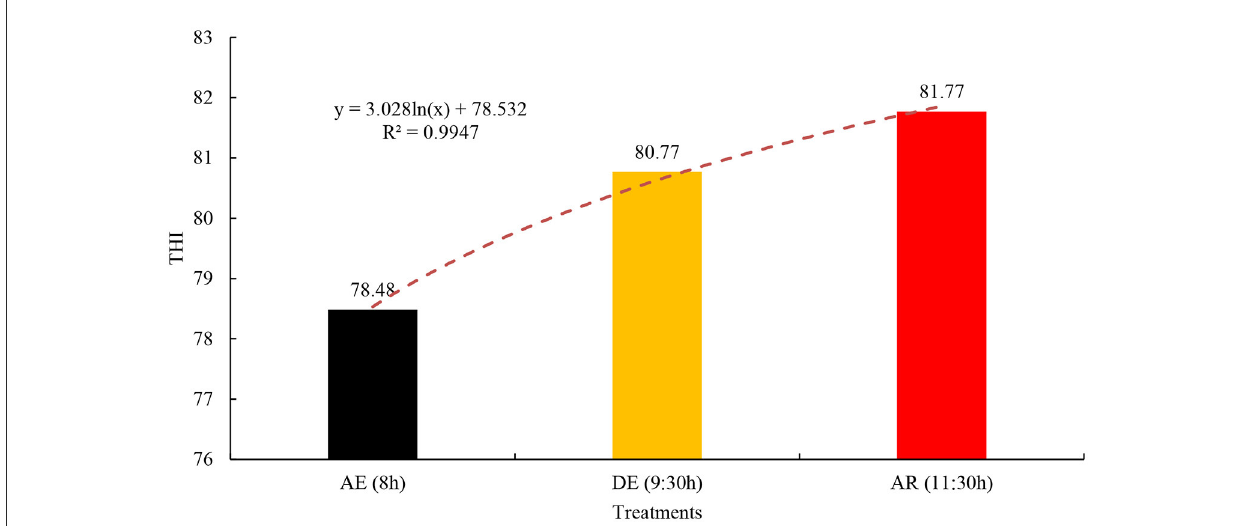
FIGURE1 Variation of the average values of the temperature and humidity index, in three moments of equine activities, in Ananindeua, Pará, Brazil. AE, before exercise; DE, after exercise; AR, after cooling.